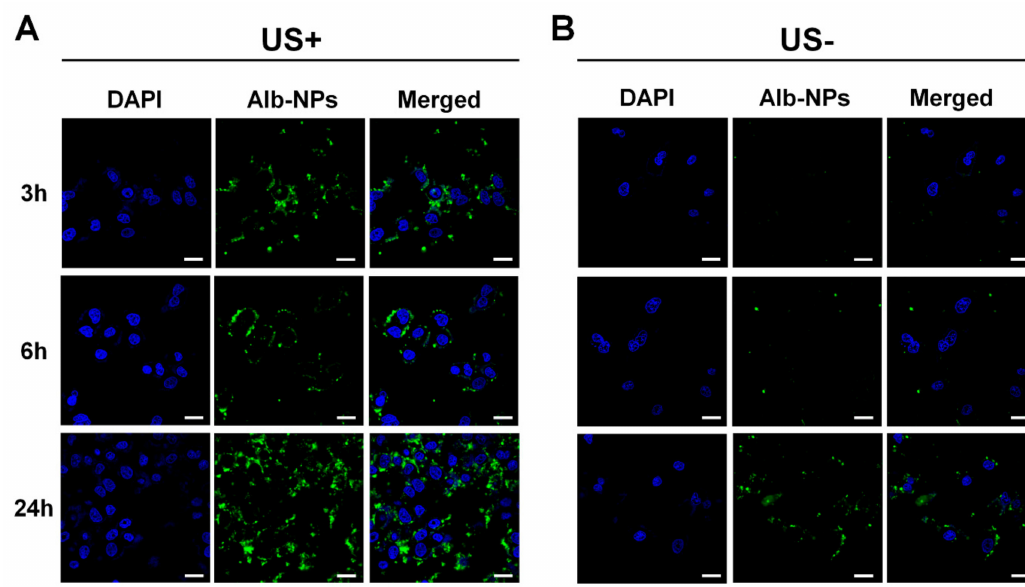
Figure 4. Cellular uptake of albumin nanoparticles after exposure of HepG2 cells to ADMBs. fluorescent image of albumin nanoparticles ( A ) under the ultrasound exposure and ( B ) without ultrasound exposure at 3, 6 and 24 h, respectively (blue; nucleus, green; albumin nanoparticle). Scale bar: 20 µ m.